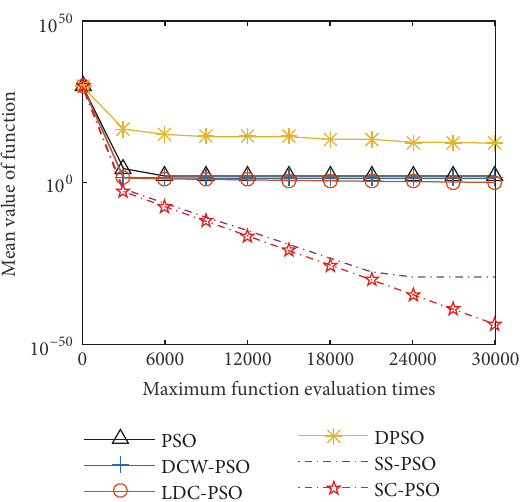
Figure 11: The function f 9 iterates over the curve.